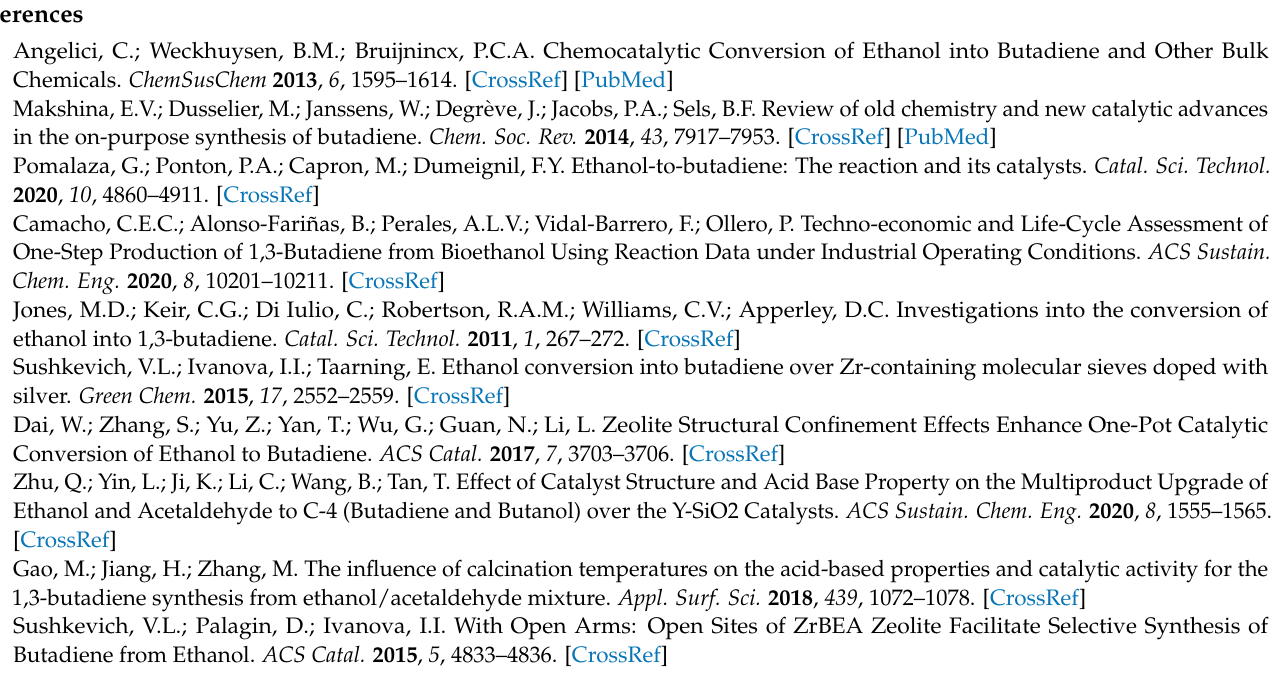
Figure S5: (a) EtOH conversion, BD yield (b) and product selectivity over Y 5 /SiBEA catalysts. (ETB reaction conditions: T = 375 ◦ C, WHSV = 1 · h − 1 ), Figure S6: (a) TGA curves, (b) DTG curves, and (c) the variations of other products and coke percentage with the different Cu/(Cu+Zn)